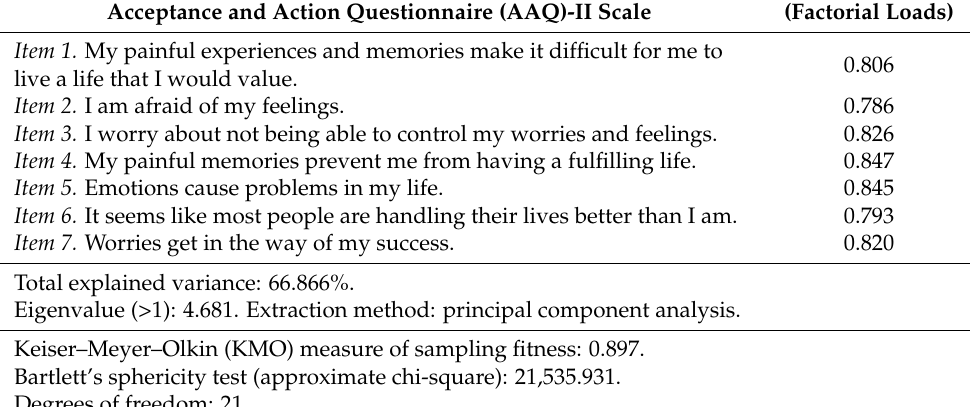
Table 2. Exploratory factorial analysis of the Acceptance and Action Questionnaire (AAQ)-II